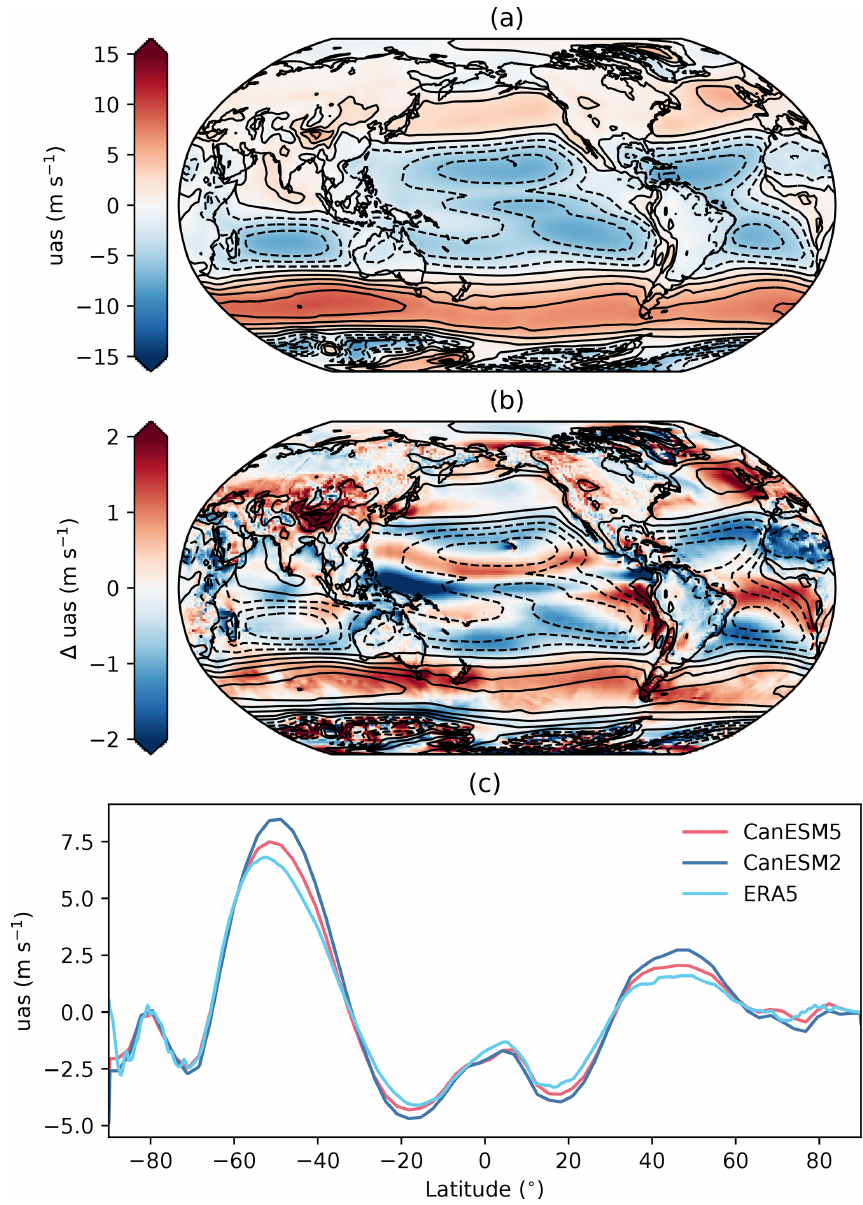
Figure 11. (a) Zonal surface winds in CanESM5, (b) the bias relative to ERA5, and (c) zonal-mean zonal surface winds in CanESM2, CanESM5, and